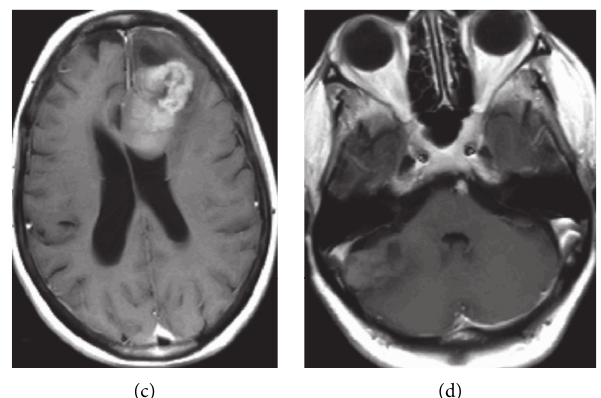
Figure 3: MRI showing the same lesions seen in the CT scan, suggestive of metastases. (a), (b) T2-FLAIR; (c), (d) contrast-enhanced T1- weighted.